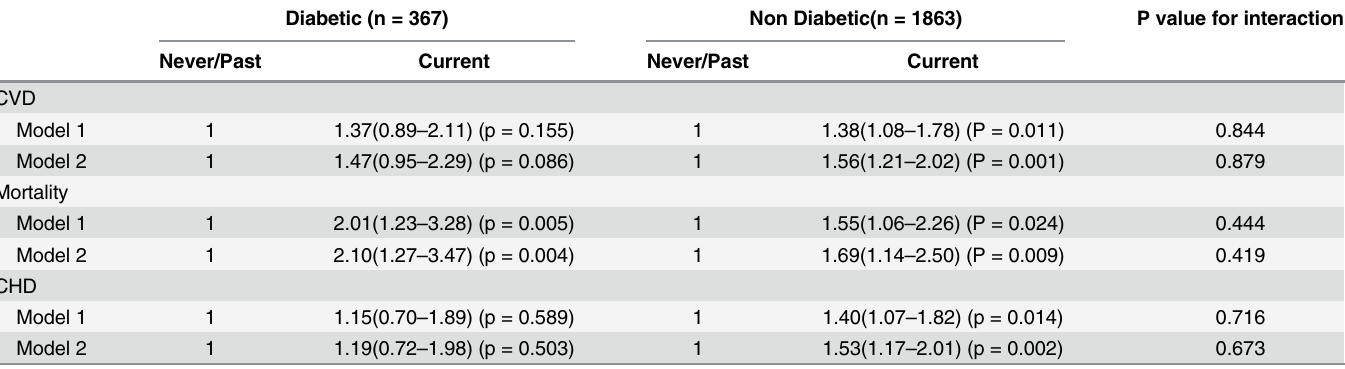
Model 1: adjusted for age; Model 2: adjusted for age, body mass index, hypertension, hypercholesterolemia, education level and eGFR. P value for interactions between smoking groups and the prevalent diabetes regarding different outcomes was calculated in multivariate analyses in a pooled sample, using likelihood-ratio